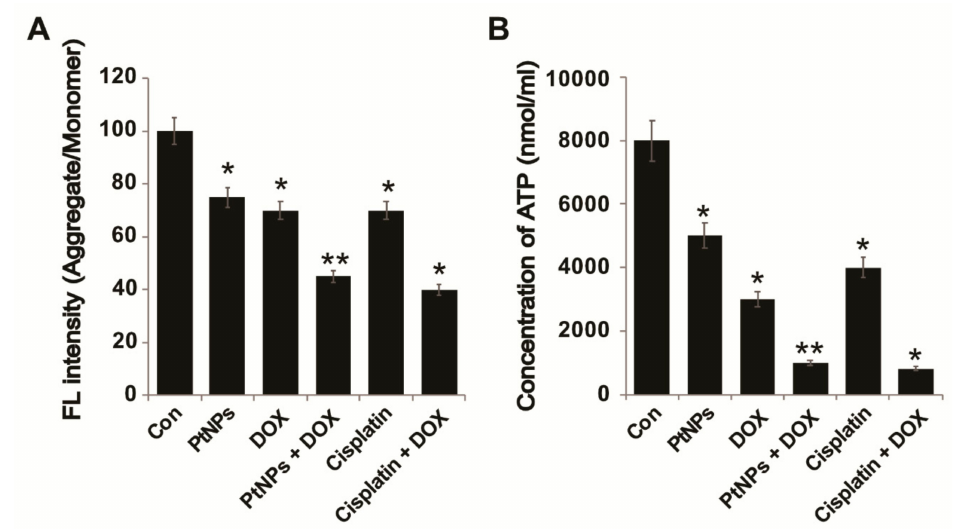
Figure 11. PtNPs and DOX decrease the MMP and ATP content. U2OS cells were treated with PtNPs (10 µ g / mL), DOX (1 µ g / mL), CIS (5 µ g / mL), or a combination of PtNPs (10 µ g / mL) and DOX (1 µ g / mL) or combination of DOX (1 µ g / mL) and CIS (5 µ g / mL) for 24 h and: ( A ) the MMP was determined using JC-1, a cationic fluorescent indicator; the ( B ) intracellular ATP content was determined according to the manufacturer’s instructions (Sigma-Aldrich, St. Louis, MO, USA; Catalog Number MAK135). Di ff erences between the treated and control groups were measured using Student’s t -test and statistically significant di ff erences are indicated by * ( p < 0.05). The results are presented as mean ± standard deviation of three experiments. * p < 0.05 was considered significant; ** p < 0.01 was considered highly significant and *** p < 0.001 was considered very highly